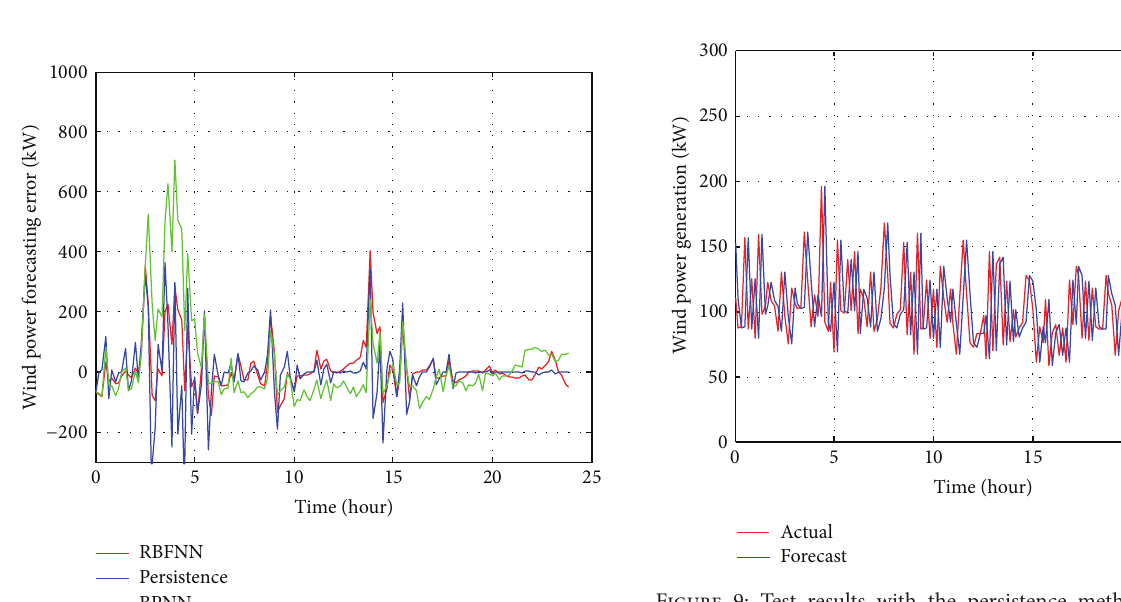
Figure 9: Test results with the persistence method for typical summer